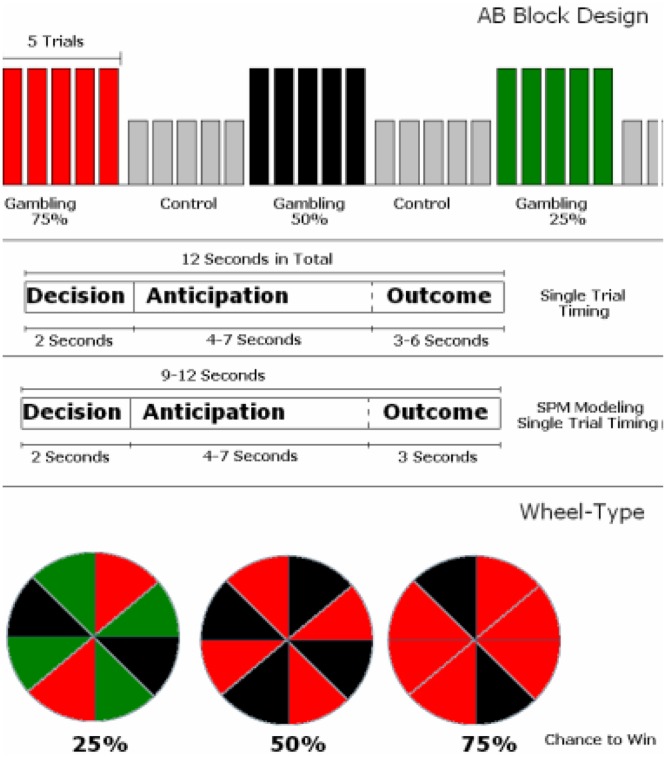
Experimental Design of the Rewarded Gambling Task.(Top) The task had a blocked design where gambling blocks were interleaved with control blocks. Each block consisted of 5 trials, each of 12 seconds length. (Middle) Each trial was 12 seconds long and included a 2 second decision period where a wheel (see bottom) was presented which indicated the perceived probability of winning on this trial. During gambling trials participants were required to make a choice (Red or Black) or they would simply lose the compulsory £1 wager automatically. In the control condition, subject were still asked to make a choice but were limited to colours other than Red and Black and no money was wagered. Following the decision, a variable anticipatory delay (4–7 seconds) preceded a 3–6 second outcome phase where the participant was informed of the outcome of the trial and their balance was amended. Three wheel types were available, each indicating the probability of winning the participant should expect on that trial.